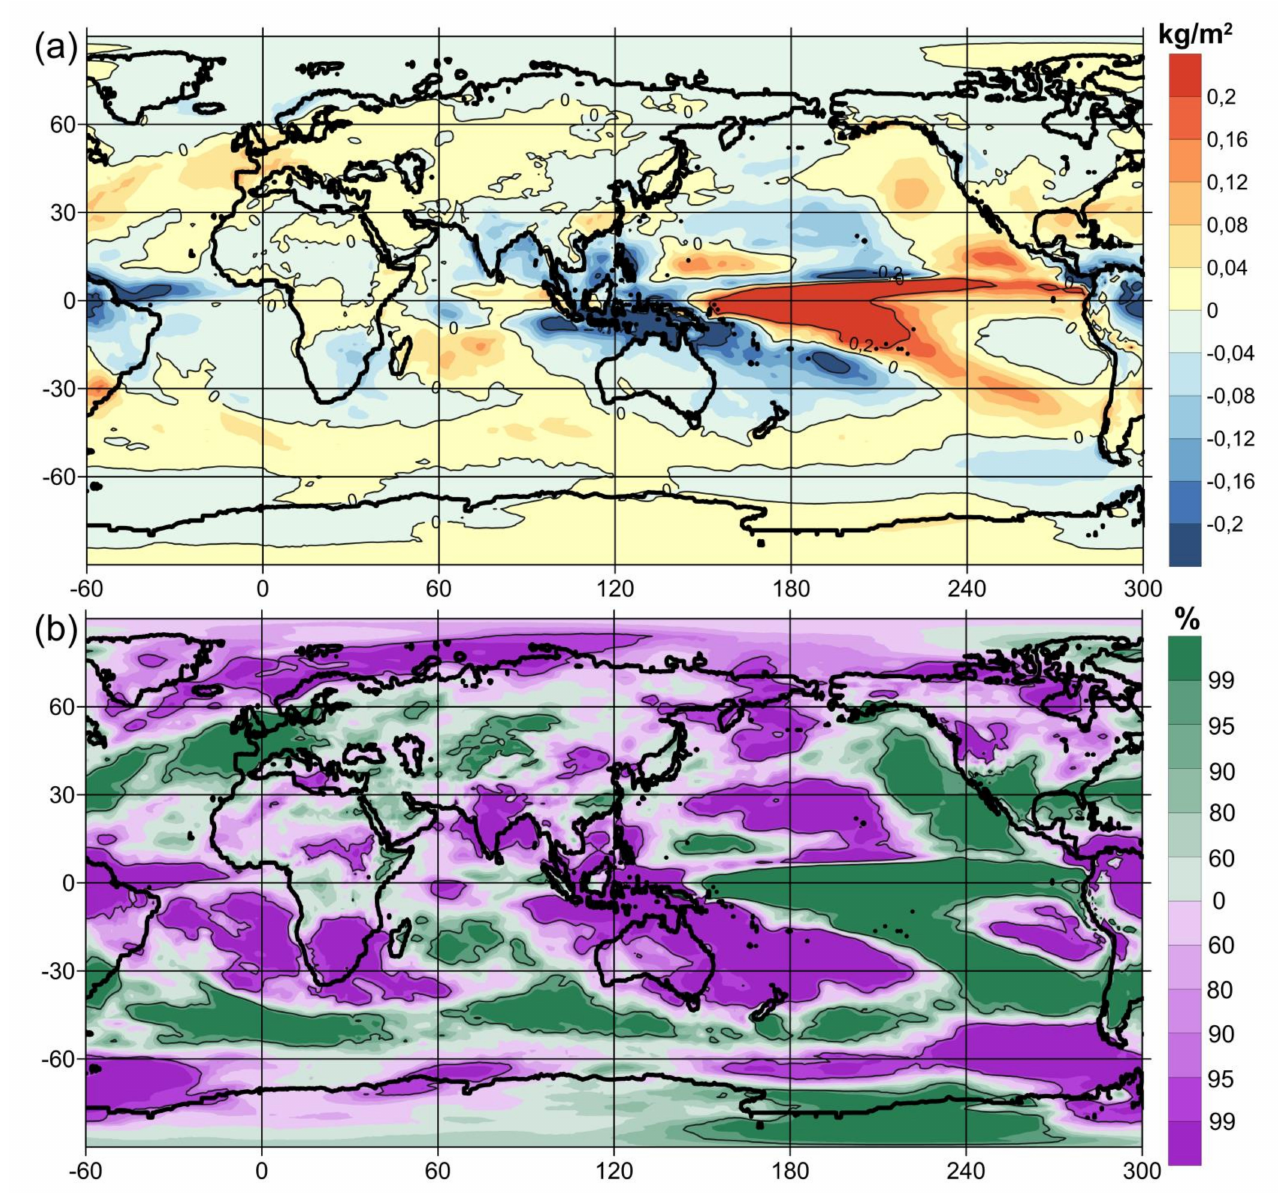
Figure 8. The difference between the average anomalies of the total amount of precipitation for a month on the surface between the opposite phases of the Global Atmospheric Oscillation by GAO2 index ( a ). The probability values for ( a ) according to Student’s t -test ( b